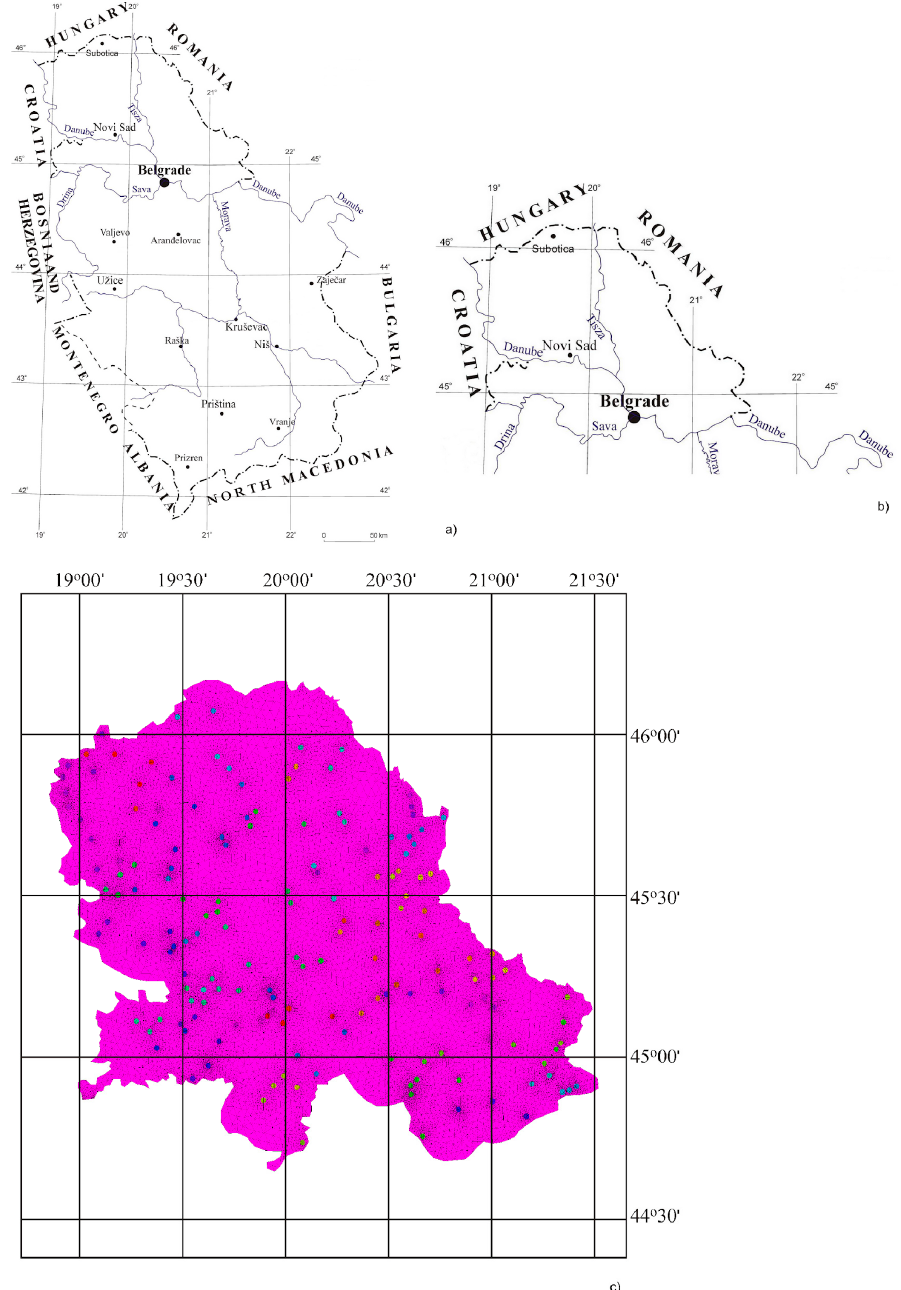
Figure 1. ( a ) Map of Republic of Serbia, ( b ) Map of the Autonomous Province of Vojvodina, ( c ) Distribution of HM concentrations in soil samples. ( c ) Distribution of HM concentrations in soil